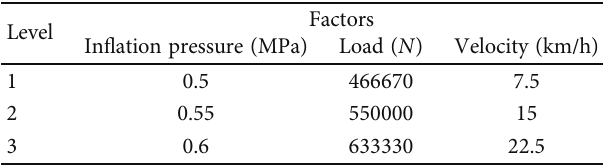
Figure 5: Schematic representation of the three-dimensional static loading process for the tire model. Table 5: Design table of orthogonal experiment of tire.